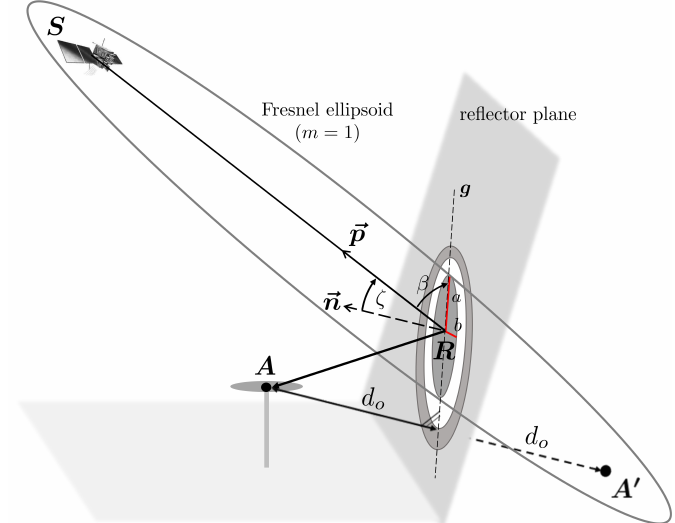
Figure 7. Intersection of Fresnel ellipsoid of the first order with an arbitrarily oriented reflector